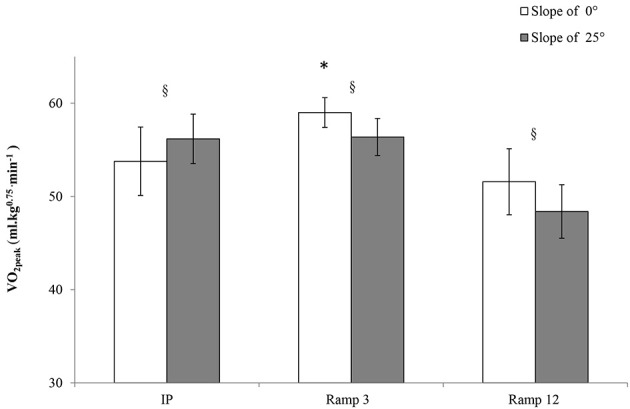
VO2peak in each exercise protocol : one-year-old sedentary FVB/N mice (n = 8) performed six exhaustive exercise protocols with a treadmill slope of 25 or 0°. IP, an incremental protocol with a starting speed of 10 m.min−1 and an increment of 3 m.min−1 every 3 min; Ramp3, a ramp protocol with a starting speed of 3 m.min−1 and an acceleration of 3 m.min−2 (0.05 m.min−1.s−1); Ramp12, a ramp protocol with a starting speed of 3 m.min−1 and an acceleration of 12 m.min−2 (0.2 m.min−1.s−1); §, a significant difference between 25 and 0° for the same protocol (p < 0.05); *, differs significantly from all other protocols (p < 0.05).